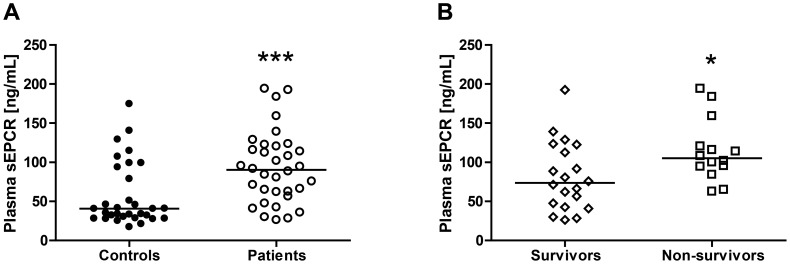
Plasma sEPCR levels of patients with culture proven melioidosis.Increased levels of sEPCR in plasma of patients (n = 34) with septic melioidosis compared to healthy controls (n = 32) (A). Increased levels of sEPCR in patients who died of melioidosis (n = 14) compared to patients that survived (n = 20) (B). Horizontal lines represent medians. ***P<0.001 for the difference between patients and controls; *P<0.05 for the difference between survivors (n = 20) and non-survivors (n = 14) (Mann-Whitney U test).